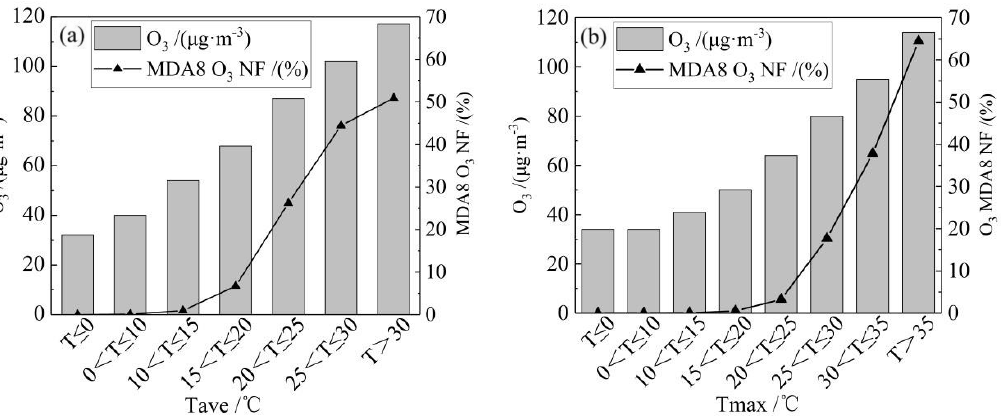
Figure 8. Average O 3 mass concentration and MDA8 O 3 nonattainment frequency (NF) in different temperature ranges, T ave ( a ) and T max ( b ).